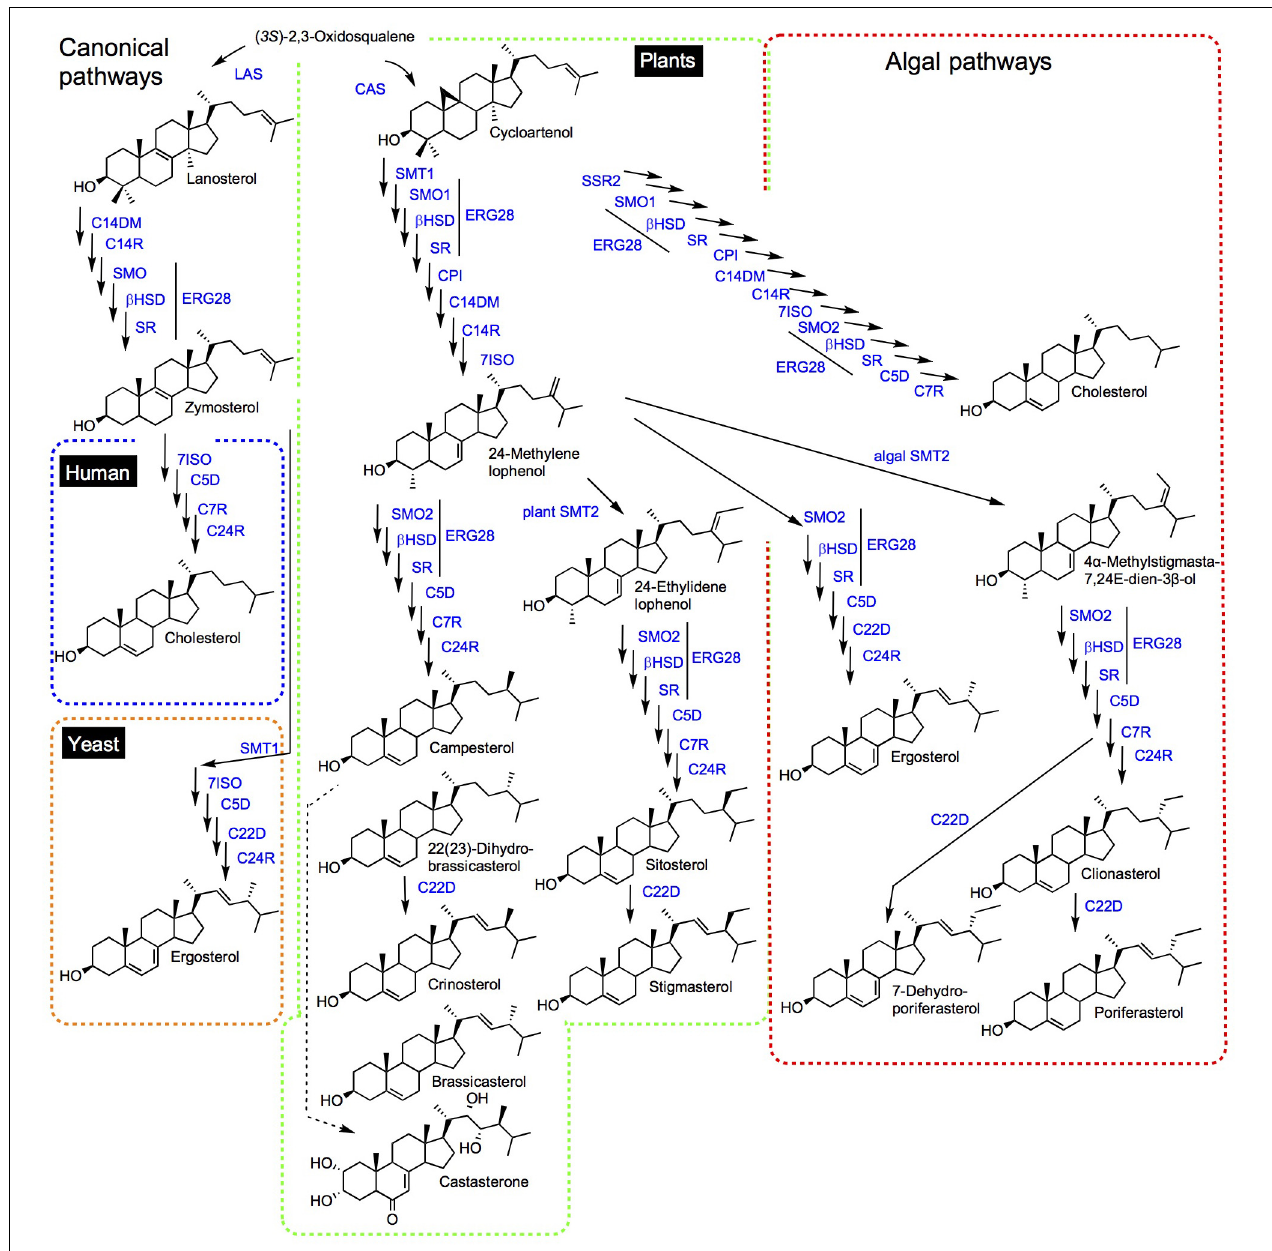
FIGURE 1 | Synthetic view of sterol pathways. Dashed lines discriminate mammalian (blue), fungal (red), and plants (green) canonical pathways. The so-called non-canonical pathways shown for algae is framed in mixed red and green colors to point out (cid:49) 5 , 7 -sterols in both fungal and algal groups, and to recall common side chain modifying enzymes SSR2 and SMTs. Substrate-product enzymatic conversion is visualized with a single arrow. The dashed line between campesterol and castasterone (brassinosteroids) represents multiple steps. Sterol names are non-systematic names. The comprehensive IUPAC recommendations and conventional system for sterol nomenclature based on cholestane, ergostane, and stigmastane scaffolds, and the associated stereochemistry is given in Moss (1989) and also commented in Nes (2011). LAS, lanosterol synthase; CAS, cycloartenol synthase; C14DM, sterol-14-demethylase; C14R, sterol-14-reductase; SMO, sterol methyl oxidase; β HSD, 3 β -hydroxysteroid dehydrogenase/C4-decarboxylase; SR, sterone ketoreductase; 7ISO, sterol-7(8)-isomerase; C5D, sterol-5(6)-desaturase; C7R, sterol-7-reductase; C24R, sterol-24-reductase; SMT1, sterol-C24-methyltransferase; SMT2, sterol-C28-methyltransferase; CPI, cyclopropyl isomerase; and C22D,